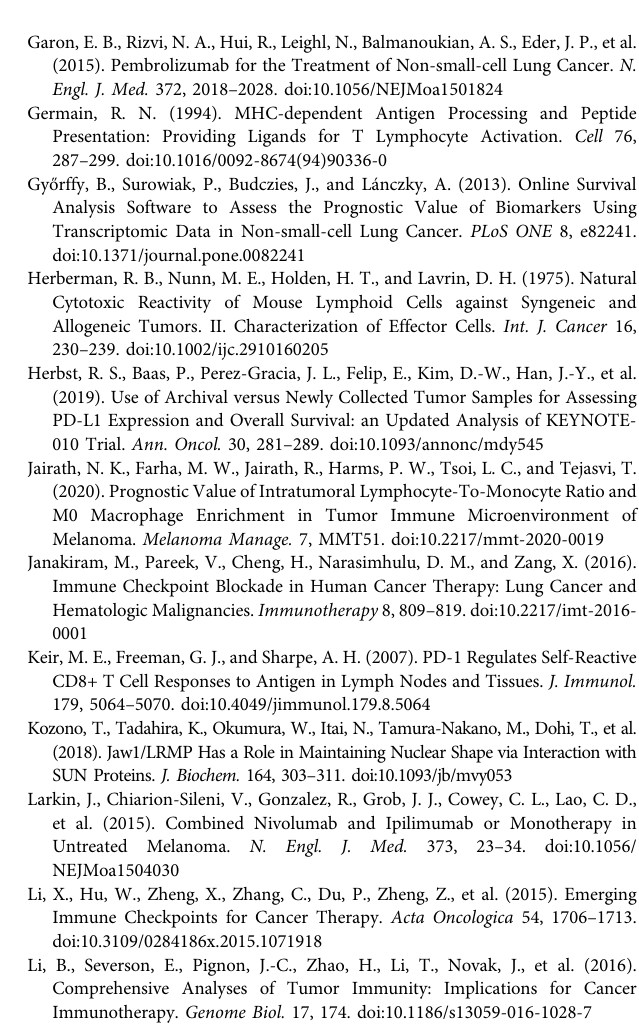
Supplementary Figure S1 | (A) LRMP mRNA level in different stages of LUAD. (B-C) LRMP mRNA level analysis according to EGFR or ALK mutation and wild type. Supplementary Figure S2 | (A) Lymphoid-restricted membrane protein (LRMP) co-expression genes expression in different cancer types. (B) Relationship between LRMP co-expressed genes and TNM stage in lung adenocarcinoma (LUAD). (C) Analysis of LRMP co-expressed genes in LUAD overall survival. Supplementary Figure S3 | (A) LRMP mRNA level was upregulated after transfection in A549 cells. (B) Changes of genes co-expressed with LRMP in overexpressed A549 cell lines. Supplementary Figure S4 | PD-L1 (CD274) expression inA549 cells with LRMP overexpression. SupplementaryTableS1| CorrelationofLRMPandgenemarkersinimmunecells. Supplementary Table S2 | GSEA pathways upregulationin high expression of